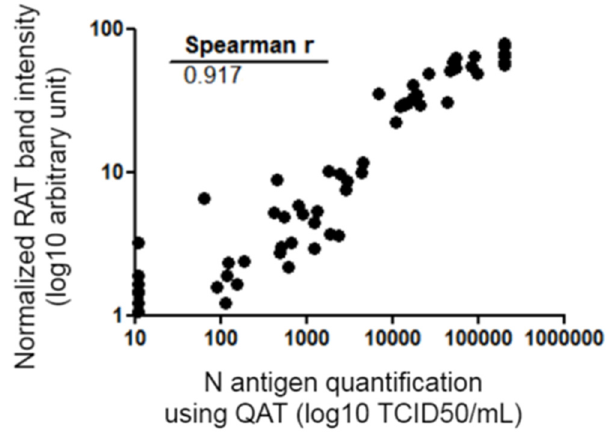
Figure 4. Spearman correlation of the quantitative data of RAT and QAT. QAT results are expressed as TCID 50 /mL (logarithmic scale) and represented on the abscissa. RAT quantitative results are expressed as band intensities (logarithmic scale) quantified using ImageJ ® tool after normalization and represented on the ordinate. Correlation coefficient r calculated with Spearman formula is shown on the graph. Ct: crossing threshold; N protein: viral nucleocapsid protein; QAT: quantitative antigen test; RAT: rapid antigen test; TCID 50 /mL 50% tissue culture infectious dose per milliliter.